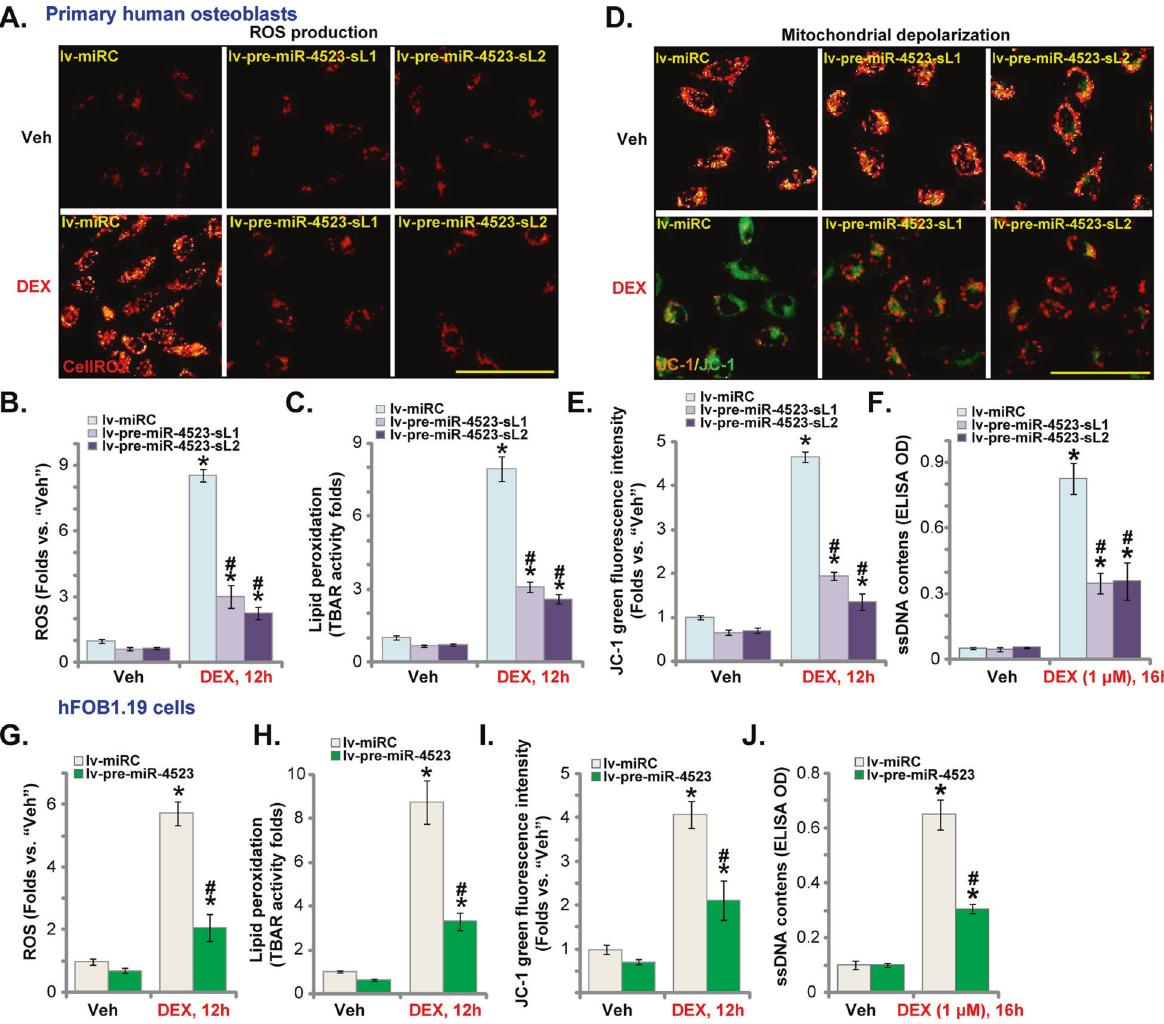
Fig. 3 miR-4523 overexpression attenuates DEX-induced oxidative injury in human osteoblasts. Primary human osteoblasts ( A – F ) or hFOB1.19 osteoblastic cells ( G – J ), stably expressing a lentiviral construct encoding the pre-miR-4523 ( “ lv-pre-miR-4523 ” ) or control miR construct (lv-miRC), were established. Cells were then treated with dexamethasone (DEX, 1 μ M) or vehicle control ( “ Veh ” ) and cultured for applied time periods. Cellular ROS contents ( A , B , and G ), lipid peroxidation intensity ( C and H ), mitochondrial depolarization ( D , E , and I ), and single-strand DNA contents (ELISA OD, F and J ) were tested by the assays mentioned in the text. Data were presented as mean ± standard deviation (SD, n = 5). * P < 0.05 versus “ Veh ” treatment in “ lv-miRC ” cells; # P < 0.05 versus “ DEX ” treatment in “ lv-miRC ” cells. The experiments were repeated fi ve times with similar results obtained. Scale bar = 100 μ m ( A and D